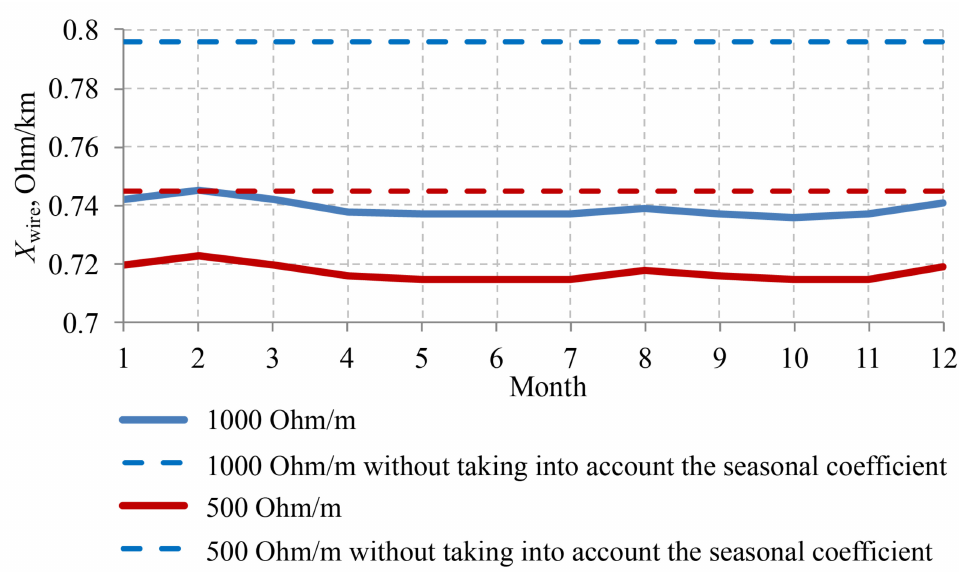
Figure 7. Changes in wire reactance by month for soil resistances of 1000 Ohm/m and 500 Ohm/m without and with taking into account the seasonal coefficient.